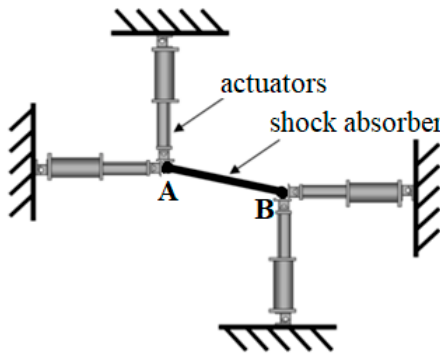
Figure 11. Method of mounting actuators to the shock absorber.